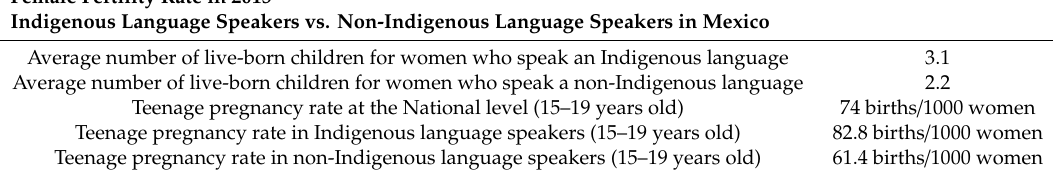
Table 4. Fertility rate. Source: CONAPO [4], INMUJERES